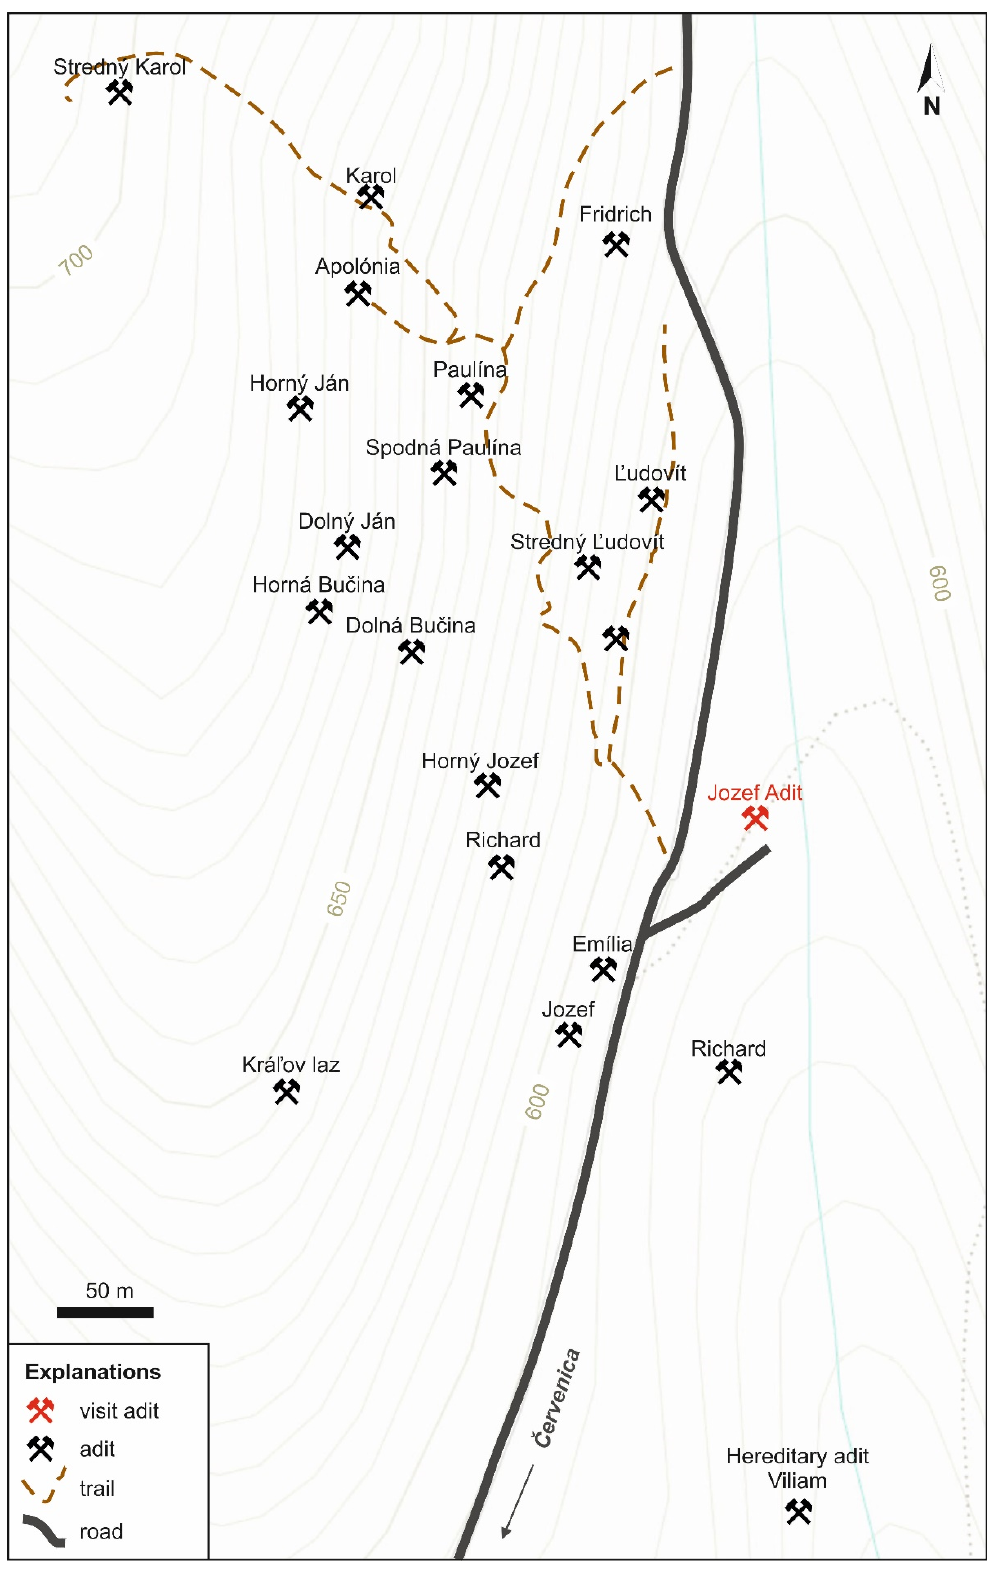
Figure 8. Map of historical mine entrances in the Libanka mining district (based on field mapping and open source data available at: www.freemap.sk (accessed on 24 November 2022)).